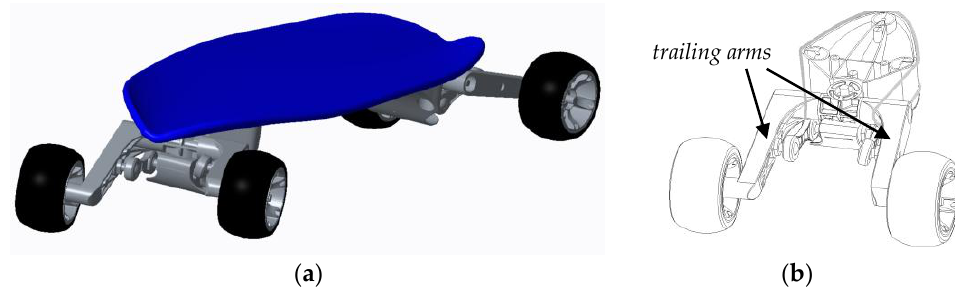
Figure 1. ( a ) CAD Model of the original trailing arm of the StreetCarver; ( b ) chassis including trailing arms.